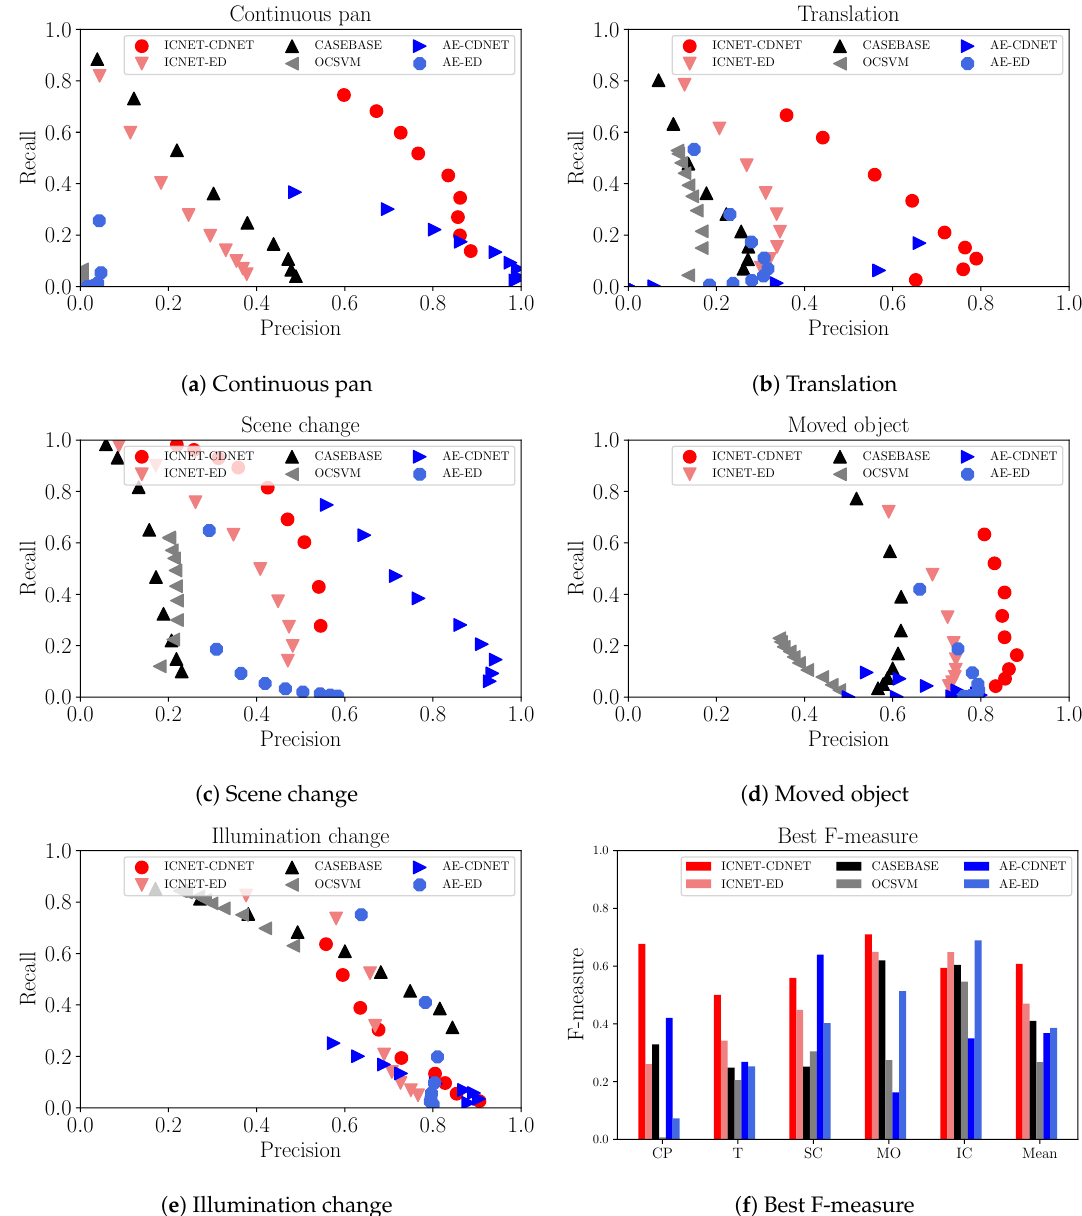
Figure 7. Evaluation on precision–recall curve and Best F-measures. We use abbreviated styles for the names of our datasets: continuous pan (CP), translation (T), scene change (SC), moved object (MO), and illumination change